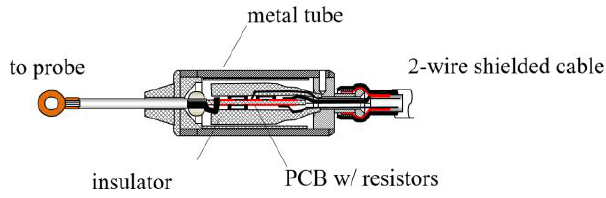
Figure 6. The design of external divider for the ion sensor.